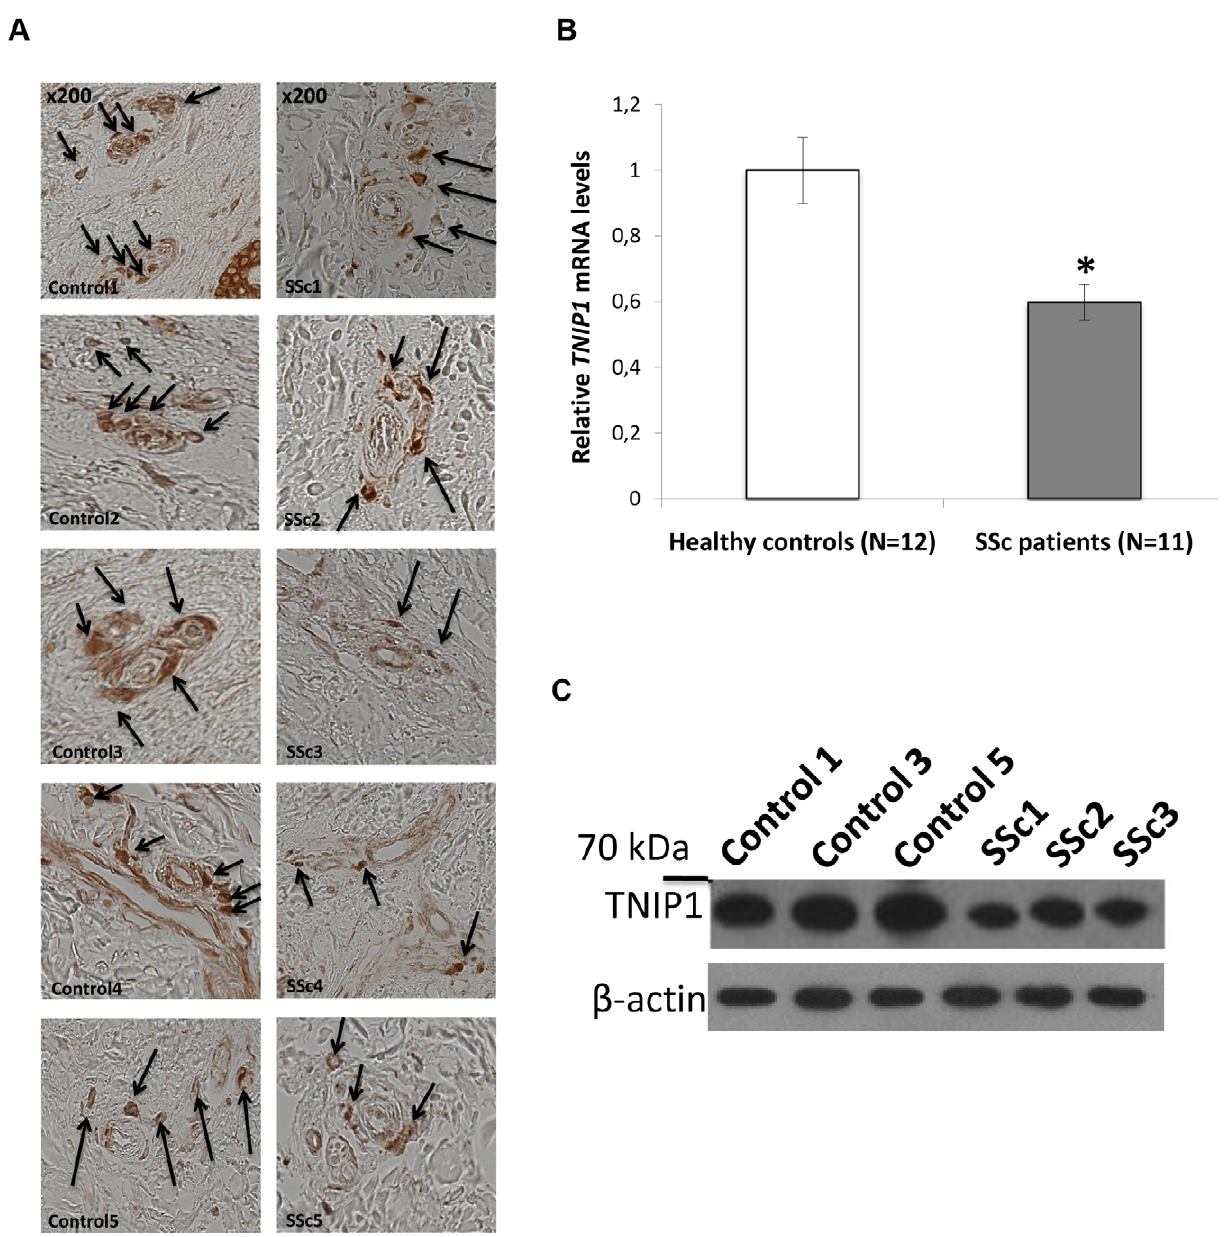
Figure 4. Decreased TNIP1 expression in SSc patients. (A) Expression of the TNIP1 protein was decreased ex vivo in SSc lesional skin tissue compared to controls (arrows indicate TNIP-1 positive cells). Shown are representative sections of the 5 patients and controls included in the analysis. (B) Consistent with these findings, a 1.7-fold decrease of TNIP1 mRNA levels was observed in dermal fibroblasts from SSc patients (* indicates a P - value=0.001 vs. controls). These results were confirmed at the protein level